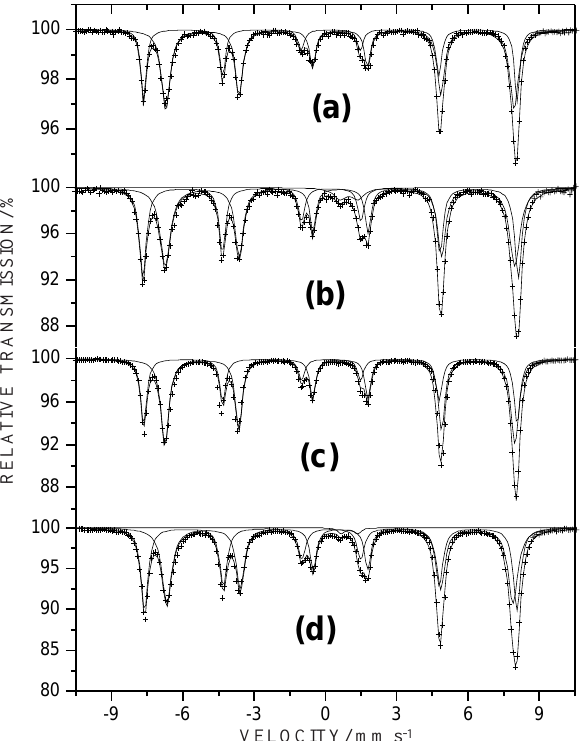
Figure 3. Room temperature Mössbauer spectra from (a) untreated magnetic extract of the fresh rock and treated 7xCBD magnetic extracts from (b) altered rock; (c) soil-sand and (d) soil-silt samples.